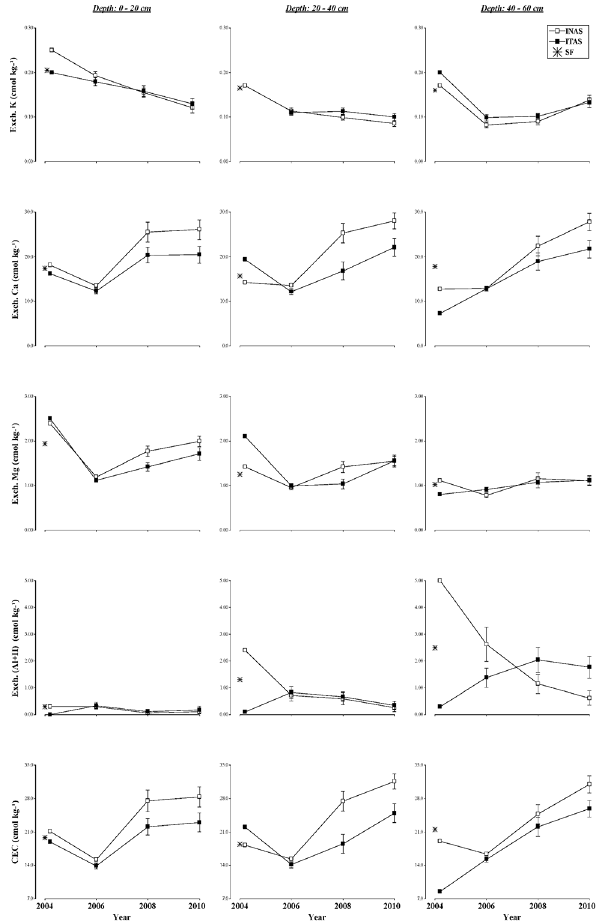
Fig 6. Changes in soil chemical properties. Under long term agroforestry management systems (INAS, ITAS) as compared to soil properties of SF at different depths (0 – 20, 20 – 40, 40 – 60 cm) during 2004 to 2010 experimental